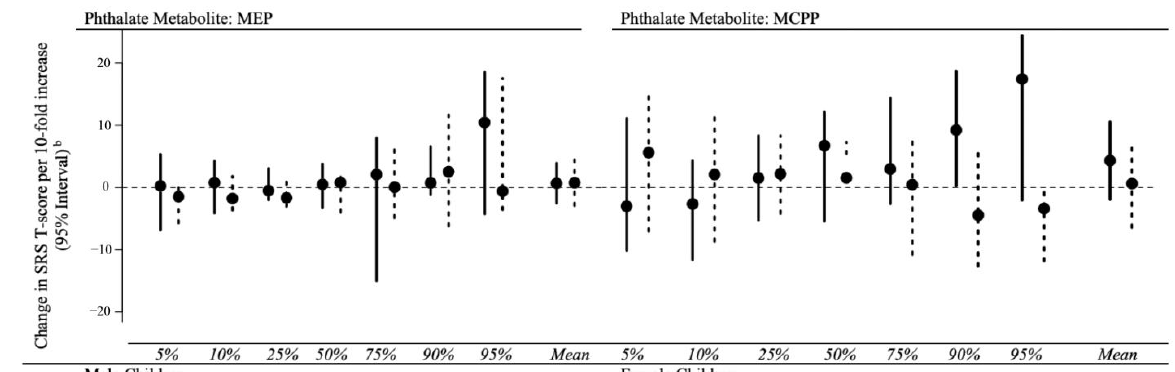
Figure 4. Adjusted differences in child SRS T-scores at 3 to 8 years per 10-fold increase in gestational maternal urinary MEP and MCPP concentrations, stratified by child sex: HOME study (2003–2006). HOME: Health Outcomes and Measures of the Environment Study, SRS: Social Responsiveness Scale, MEP: monoethyl phthalate; MCPP: mono(3-carboxypropyl) phthalate. Adjusted for maternal age (continuous), maternal race (white vs. non-white), income (<$30,000 vs. $30,000–$75,000, ≥ $75,000), parity (continuous), and log10-transformed urine/serum cotinine concentrations (continuous). Note cotinine concentrations were ascertained from maternal urine in HOME. Positive coefficients for SRS indicate that maternal phthalate exposure is associated with more deficits in social responsiveness traits. Note that values may appear to differ slightly from those reported in Table S8, as we used un-rounded values to generate these figures.